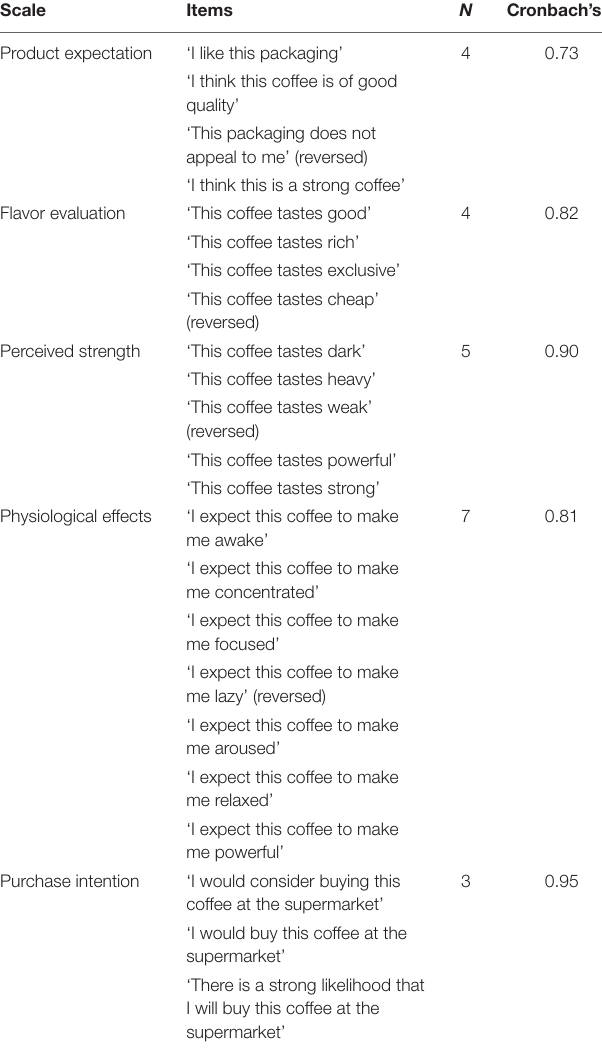
TABLE 2 | The measurement scales and the reliability of the